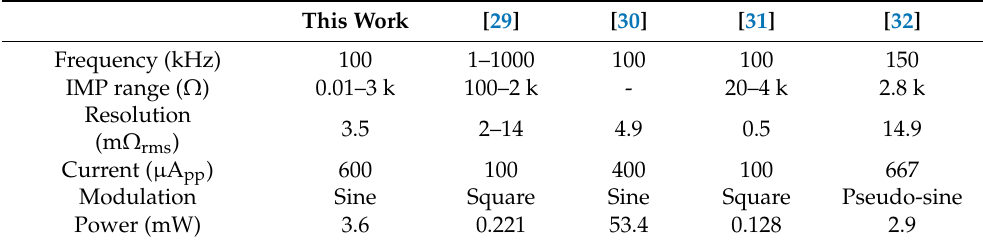
Table 4. Comparison of system